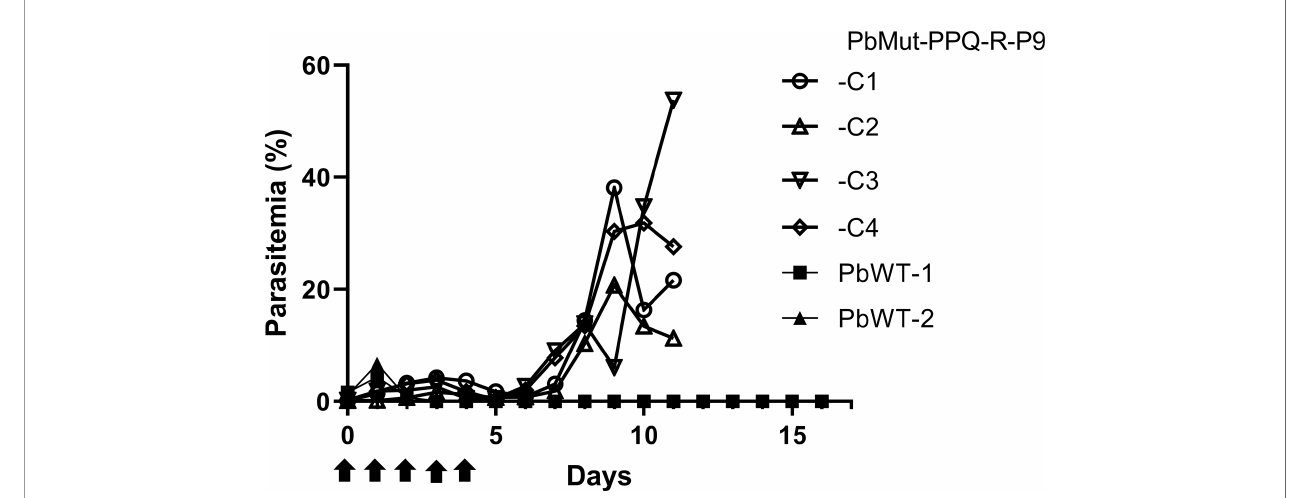
FIGURE 3 | Assessment of PPQ susceptibility in PbMut-PPQ-R-P9-derived clones. Erythrocytes (1x10 3 ) infected with two wild-type (PbWT-1 and PbWT-2, closed symbols) and four clones from PbMut-PPQ-R-P9 (open symbols) were transferred to each mouse. The mice were then treated with PPQ (15 mg/kg/day) for fi ve consecutive days (arrows), and parasitemia was